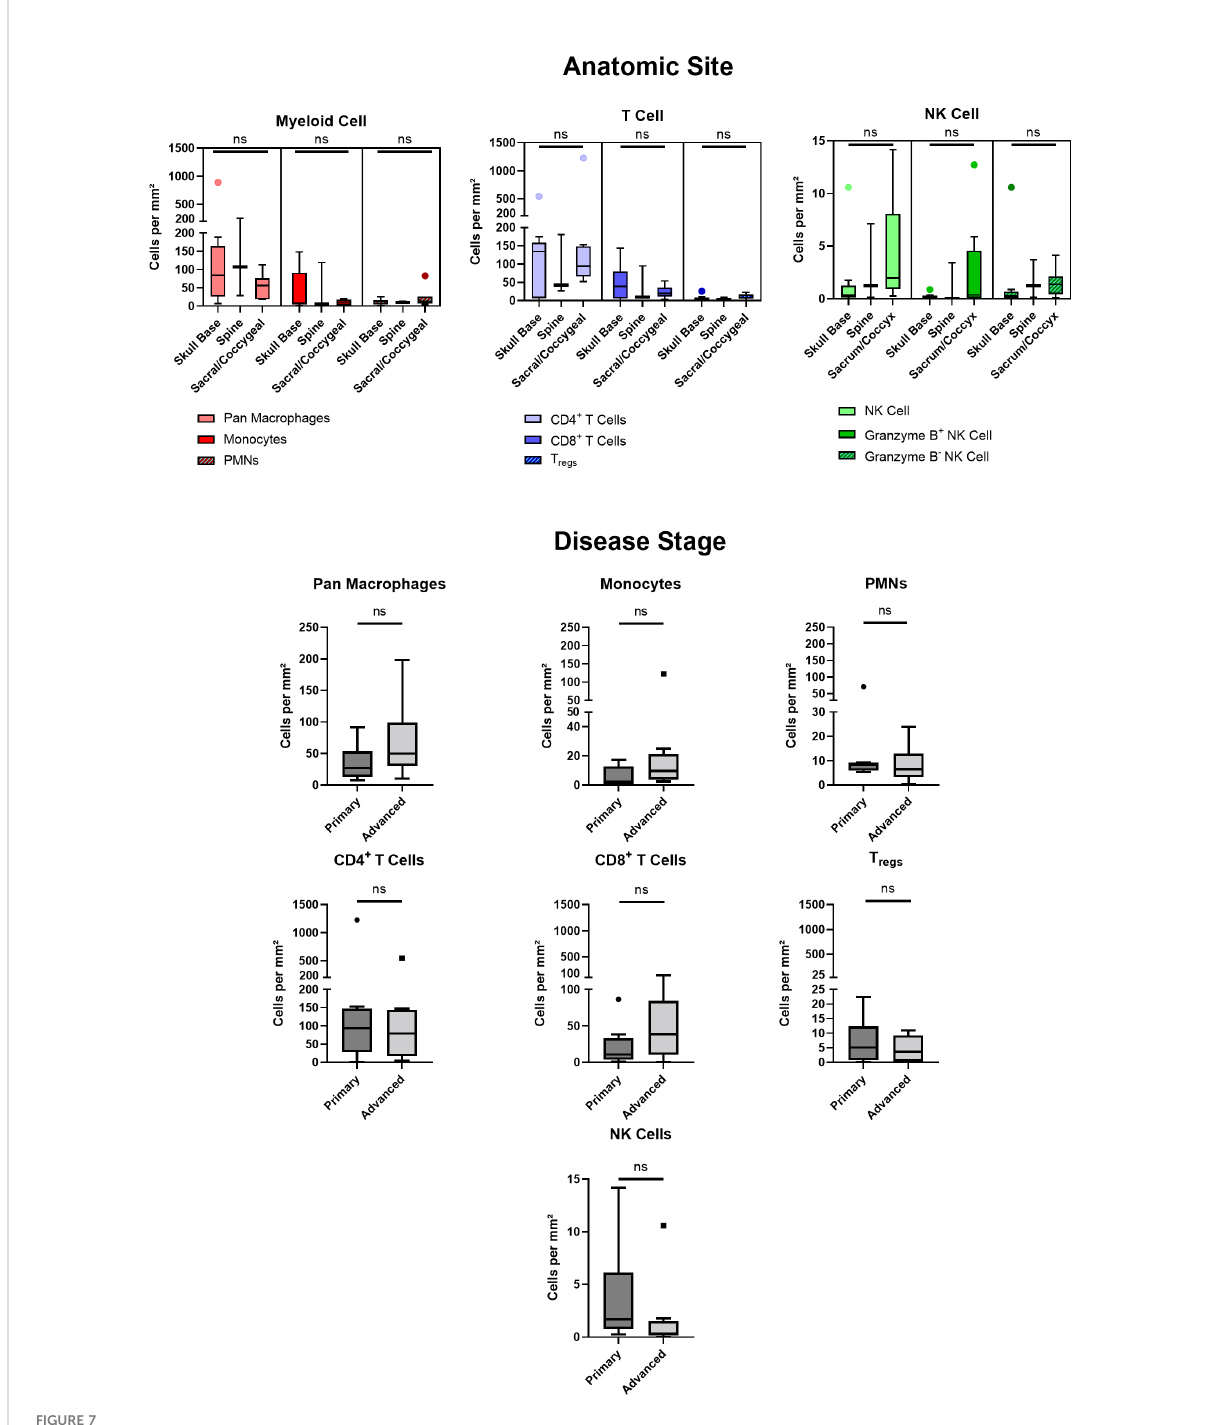
FIGURE 7 Chordoma myeloid, T cell, and NK cell density does not signi fi cantly differ by anatomic site. Immune in fi ltrate differences among chordomas (n = 20) originating from skull base (n = 9), spine (n = 3), or sacrum/coccyx (n = 8) were assessed with two-way ANOVA analysis using a p value threshold of <0.05. Chordoma myeloid, T cell, and NK cell density does not signi fi cantly differ by disease stage. Immune in fi ltrate differences between chordoma patients (n = 20) with primary and advanced disease were assessed with Mann Whitney tests using a p value threshold of <0.05. Advanced disease was de fi ned as including cases of locally progressive and locally advanced, destructive disease. ns, non signi fi cant. NK cell, natural killer